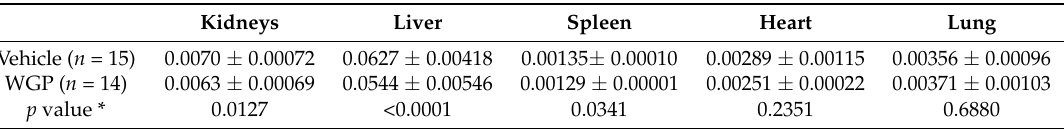
Table 1. Organ index (organ weight/bodyweight) after six months of feeding sugar (Vehicle) or whole grape powder